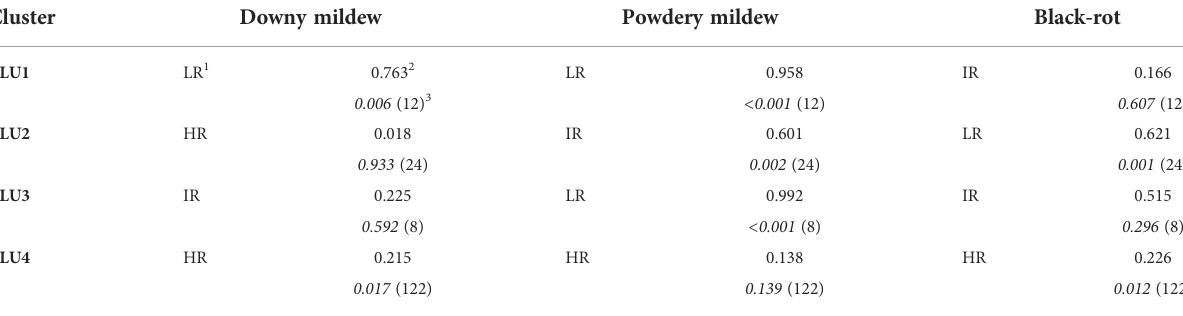
TABLE 3 Correlation coef fi cients between the AUDPC (area under the disease progress curve) values assessed on leaves and bunches for the grapevine varieties belonging to each of the four clusters shown in Figure 5 and Table 2